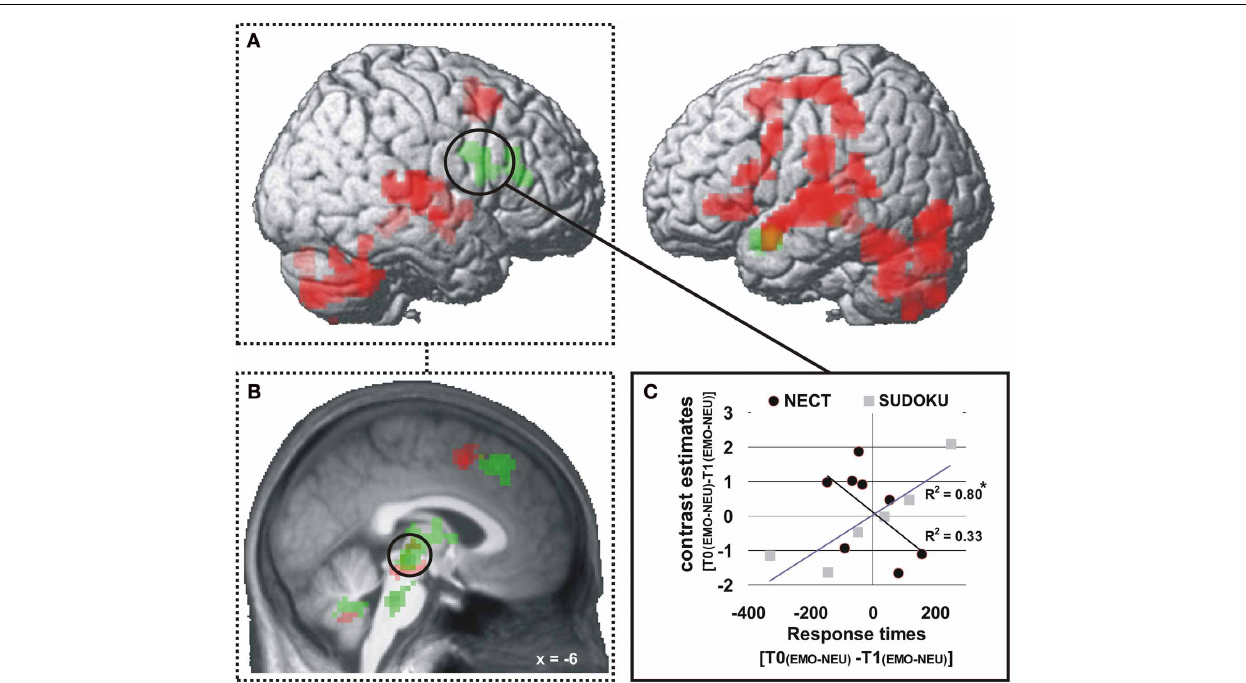
response times to neutral than to emotional cues a positive value of this interaction terms corresponds to an increase in emotion-sensitivity) and changes in cerebral responses in the SUDOKU group is reversed in the NECT group (C) ; here exemplified based on extracted mean contrast estimates from the whole-brain significant cluster in the right inferior frontal gyrus. ∗ p < 0 .